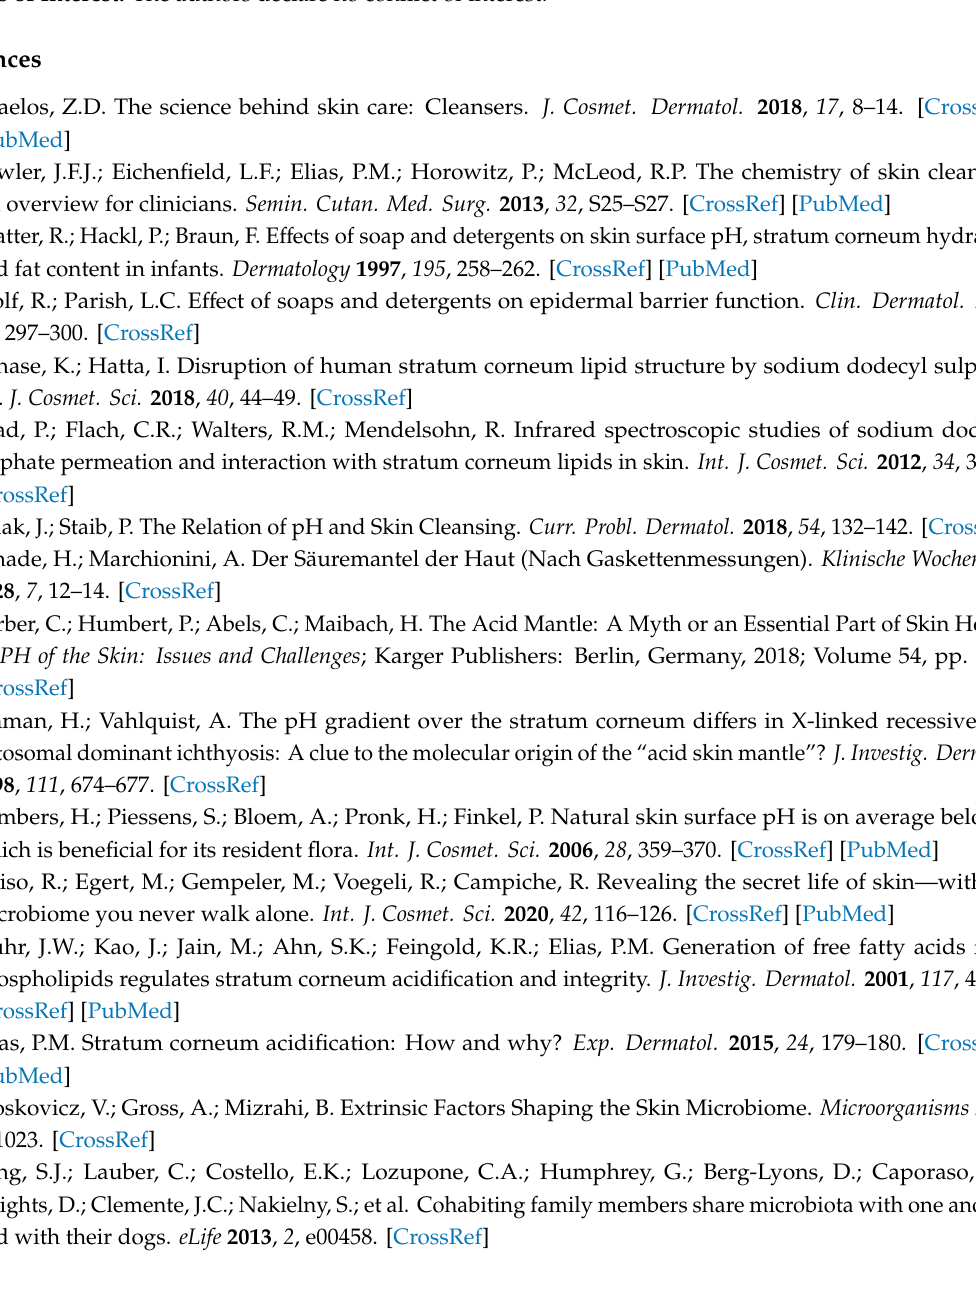
Figure S5. Bray–Curtis measure of beta-diversity between time 0 and 168 h after the first use of the active treatment. Figure S6. The top 10% of OTUs in the di ff erential rankings produced by Songbird for the placebo and treatment groups during the washout